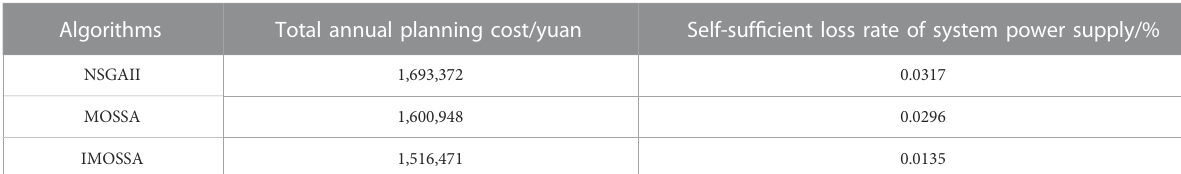
TABLE 4 Objective function values of the three algorithms.